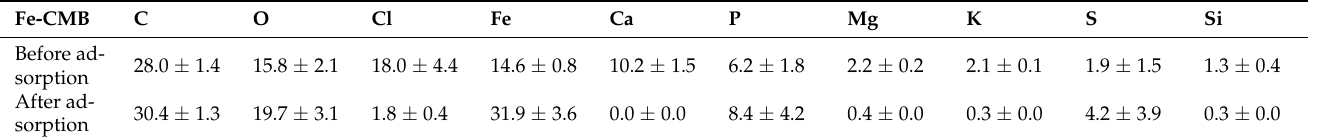
Table 1. Elemental composition (weight %) of Fe-CMB obtained from energy dispersive spectrometer. Fe-CMB C